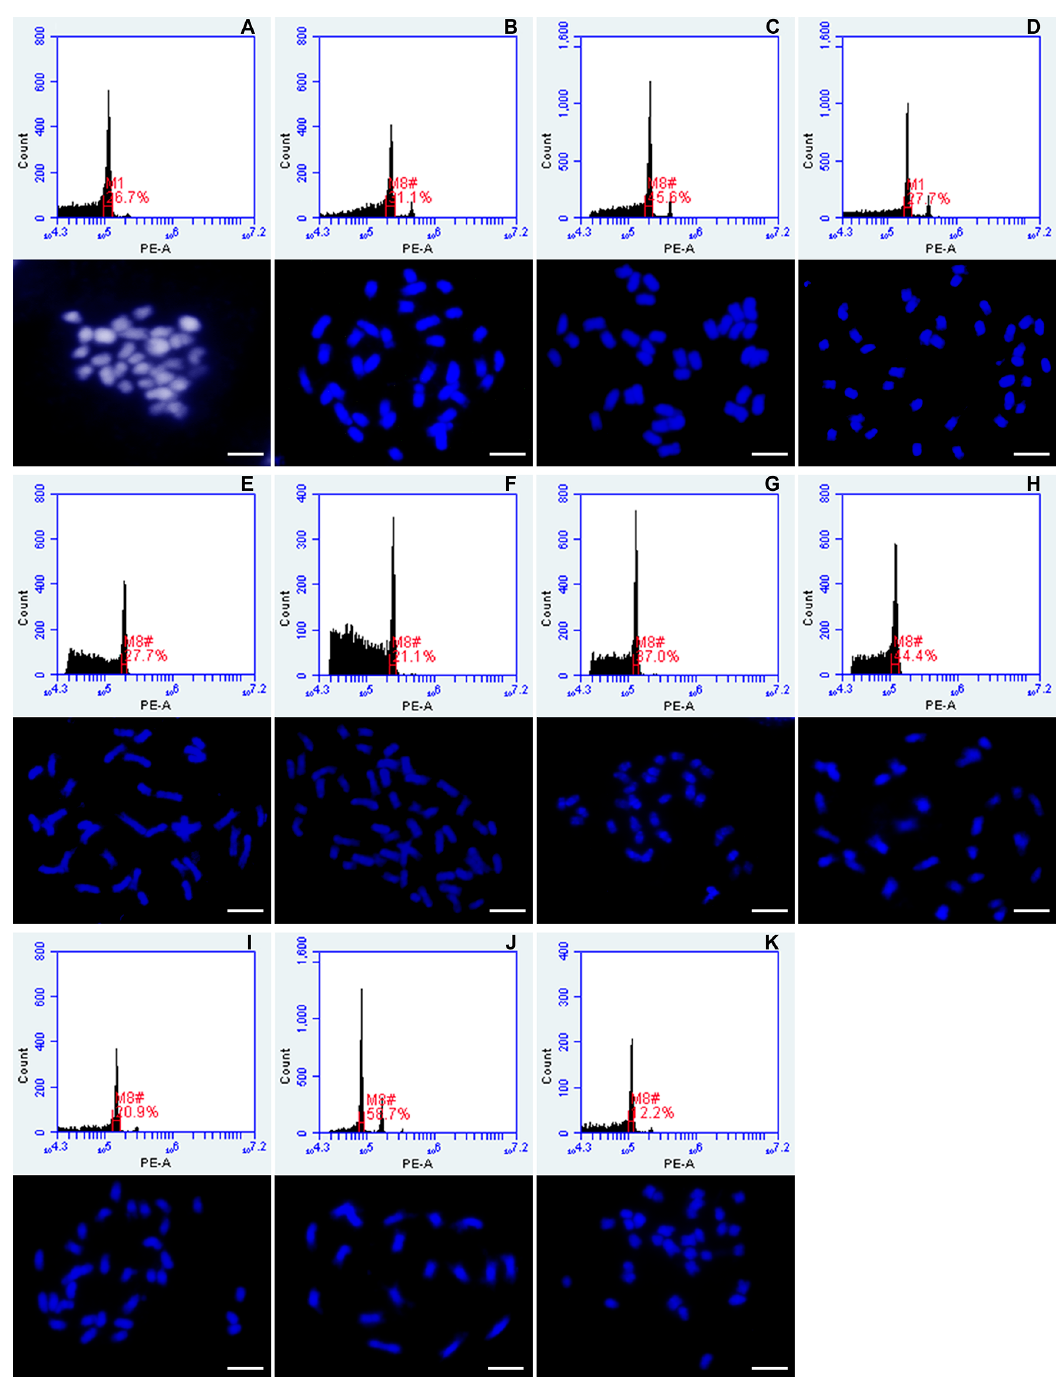
Figure 4. Histograms of relative fluorescence intensities showing ploidy levels and the corresponding chromosome numbers of different genotypes selected as potential external standards for flow cytometry analysis of Urochloa germplasm collection. ( A ) Panicum miliaceum Mil69 (2 n = 4 x = 36); ( B ) Urochloa brizantha PI 292187 (2 n = 4 x = 36); ( C ) Urochloa decumbens CIAT 664 (2 n = 4 x = 36); ( D ) Urochloa decumbens CIAT 6370 (2 n = 4 x = 36); ( E ) Urochloa humidicola CIAT 26151 (2 n = 6 x = 36); ( F ) Urochloa humidicola CIAT 16867 (2 n = 8 x + 2 or 9 x − 4 = 50), recognized as aneuploid and thus cannot be used as external standard; ( G ) Urochloa maxima CIAT 6171 (2 n = 4 x = 32); ( H ) Urochloa maxima CIAT 16004 (2 n = 4 x = 32); ( I ) Urochloa maxima PI 284156 (2 n = 4 x = 32); ( J ) Urochloa ruziziensis CIAT 6419 (2 n = 2 x = 18); ( K ) Urochloa sp. PI 657653 (2 n = 4 x = 32). Regions of identification seen in plots (red marks) were placed across the peaks to export fluorescence values representing peak positions and CVs. Scale bars = 5 μ m.